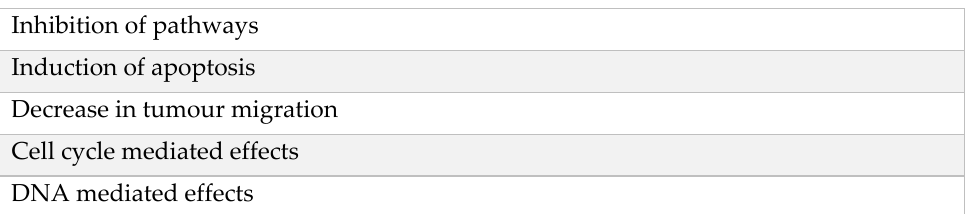
Figure 2. Proposed mechanisms of how lidocaine reduces cancer recurrence.